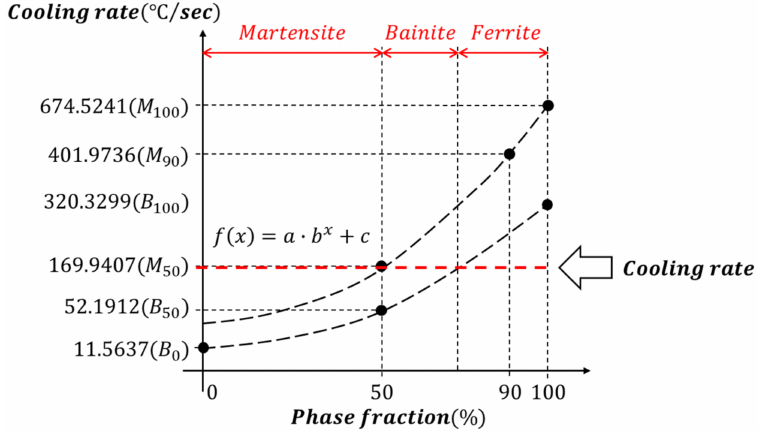
Figure 4. Phase fraction by the cooling rate.